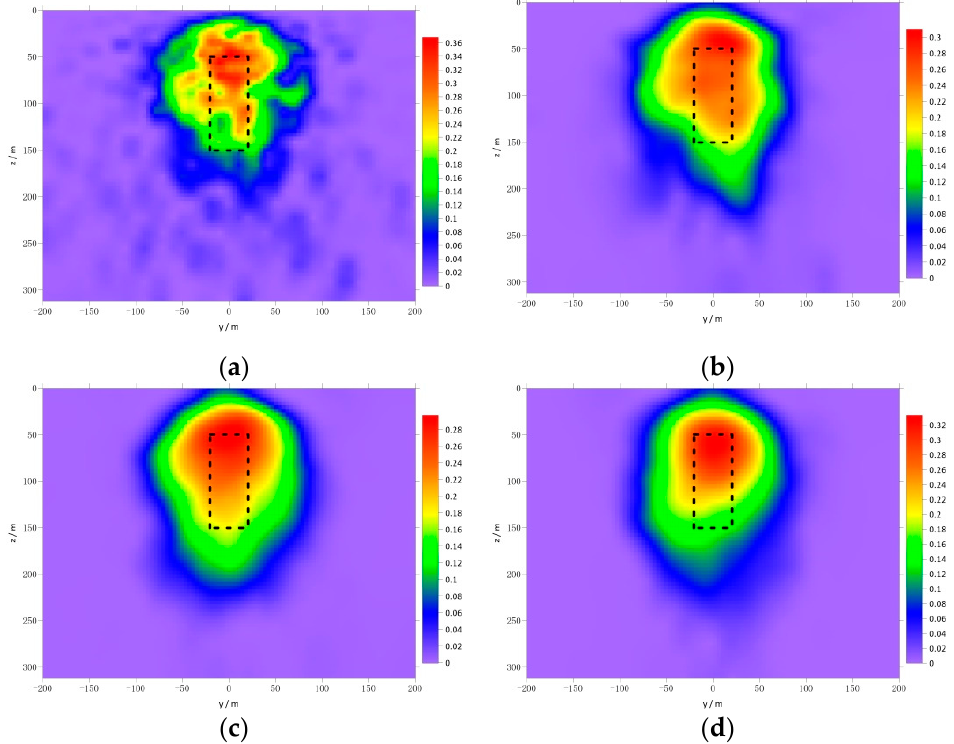
Figure 3. The inversion results of the model shown in Figure 2a with different 𝑠 (cid:3033) . ( a ) 𝑠 (cid:3033) = 0 , ( b ) 𝑠 (cid:3033) = 1 , ( c ) 𝑠 (cid:3033) = 2 , ( d ) 𝑠 (cid:3033) = 3 .